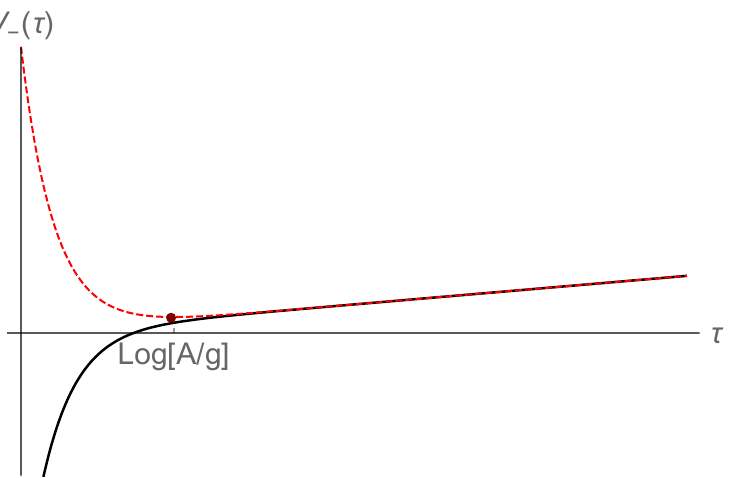
Figure 4 . The e(cid:11)ective interaction potential V values of the separation (cid:28) , (black-solid curve), this completely attractive potential is the reason why the [ I (cid:22) I ] con(cid:12)guration is viewed as unstable in the literature. The red-dashed curve correspond to the e(cid:11)ective potential on the thimble. The value (cid:28) to the [ I (cid:22) I ] amplitude integral in